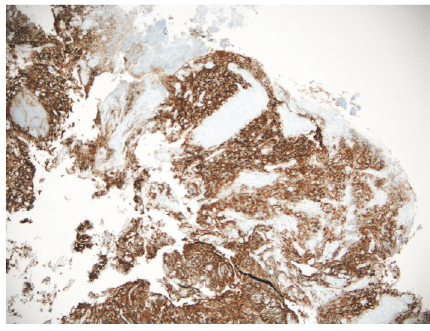
Figure 4: Duodenal mass with metastatic seminoma (PLAP IHC stain, magnification ×